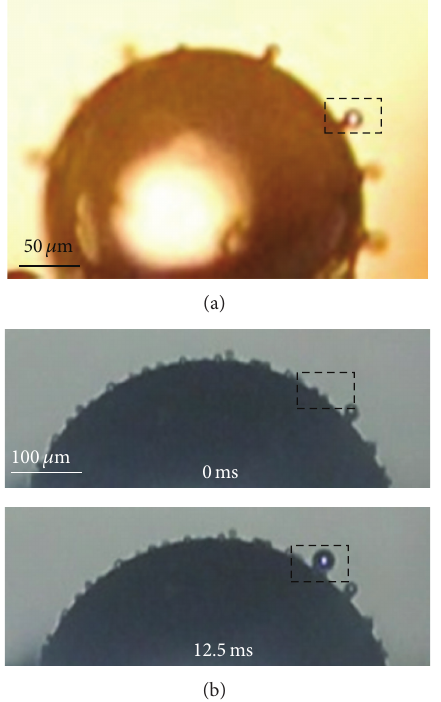
Figure 4: (a) Optical image of condensate which has previously self- propelled onto the surface of the host drop (see also Movie S6). The image of the condensate was acquired after movement into a clear field of view (i.e., in focus). (b): before and after images of a single mobiledropletimpactingontothehostdropandadheringtoasingle particle residing on the host drop (see also Movie